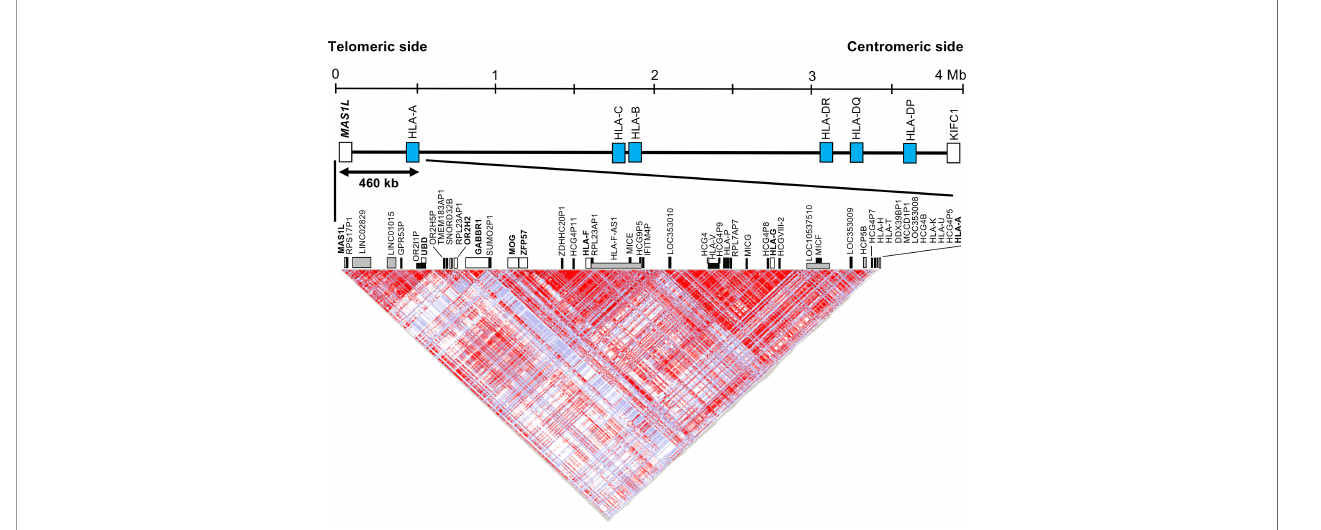
FIGURE 1 | Haplotype structure of the human leukocyte antigen (HLA) telomeric genomic region between MAS1L and HLA-A . The linkage disequilibrium (LD) plot was generated with the program HaploView Ver.4.2. The top part shows the simpli fi ed gene composition of the 4-megabase (Mb) HLA region between MAS1L and KIFC . Blue box indicates representative classical HLA loci. The bottom part shows the LD map constructed by the HaploView software. A total of 603 single- nucleotide polymorphisms (SNPs) extracted from the HapMap data (hapmap3_r3) of 113 Japanese subjects in the 460-kb HLA telomeric genomic region between MAS1L and HLA-A (GRCh38.p13, chr6: 29486712 to 29946600) were used for this analysis. White, gray, and black boxes indicate coding genes, non-coding RNA (ncRNA), and pseudogenes, respectively. Each dot represents the value of D ′ /LOD, with the standard LD color scheme: white, LOD < 2 and D ′ < 1; shade of pink/ red, LOD > 2 and D ′ < 1; blue, LOD < 2 and D ′ = 1; bright red, LOD > 2 and D ′ =